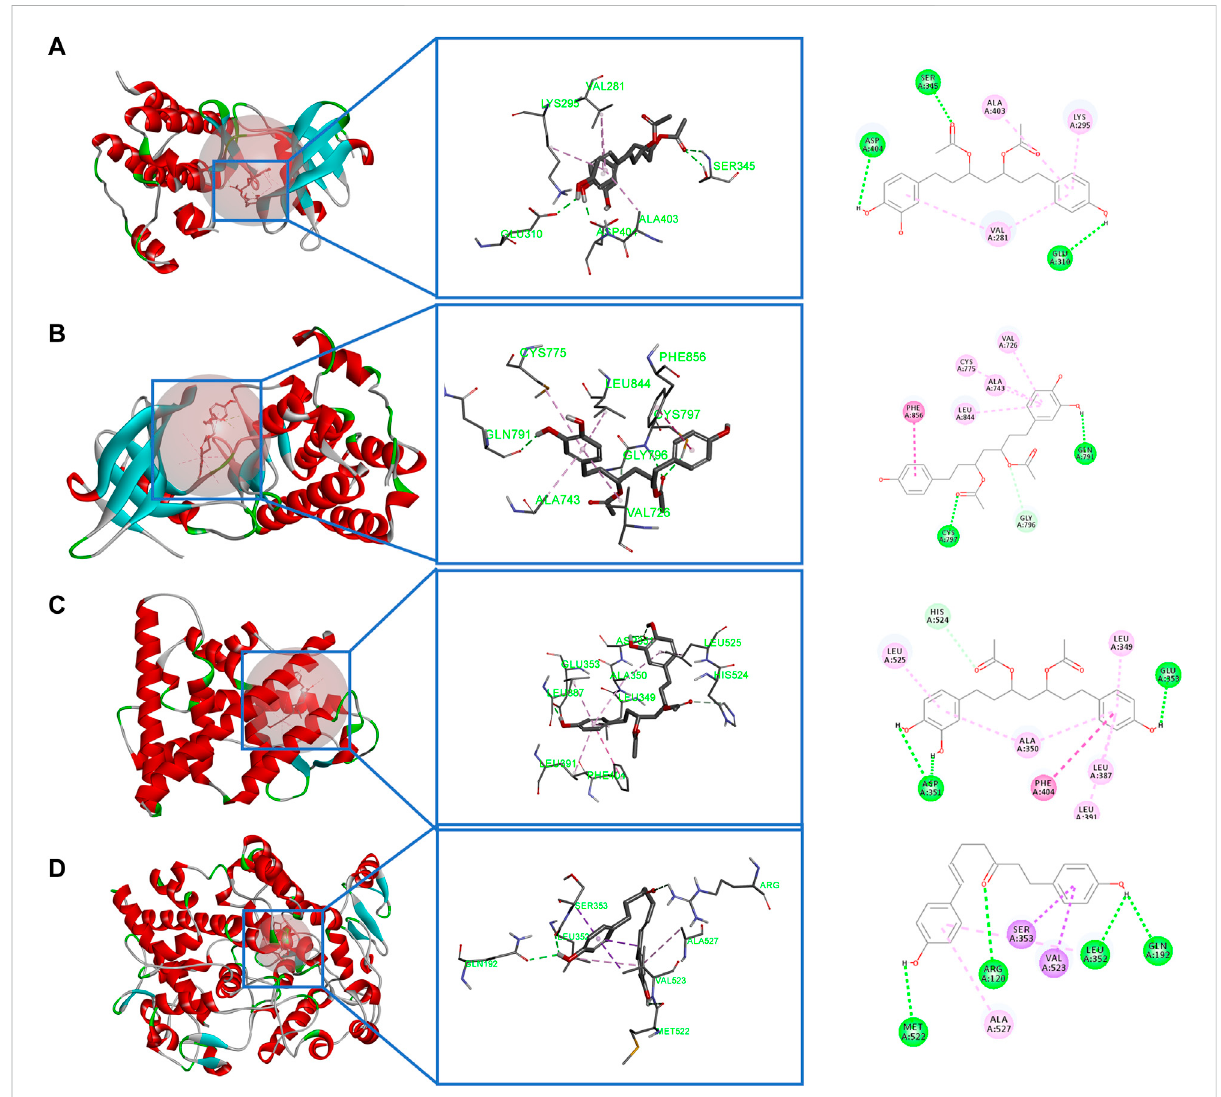
FIGURE 9 Moleculardocking. (A) Bindingmodesof3,5-diacetoxy-1-(3,4-dihydroxyphenyl)-7-(4-hydroxyphenyl)-heptaneintheSRC-bindingpocket. (B) Binding modes of 3,5-diacetoxy-1-(3,4-dihydroxyphenyl)-7-(4-hydroxyphenyl)-heptane in the EGFR-binding pocket. (C) Binding modes of 3,5- diacetoxy-1-(3,4-dihydroxyphenyl)-7-(4-hydroxyphenyl)-heptane in the ESR1-binding pocket. (D) Binding modes of 1,7-bis(4-hydroxy-3- methoxyphenyl)hepta-4,6-dien-3-one in the PTGS2-binding